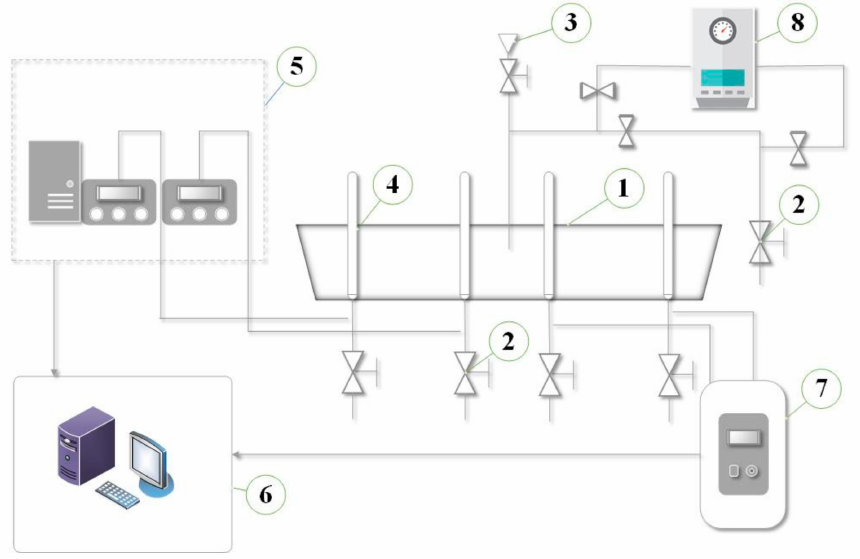
Figure 1. A schematic of the water model experiment. 1—tundish, 2—flowmeter, 3—tracer inlet,